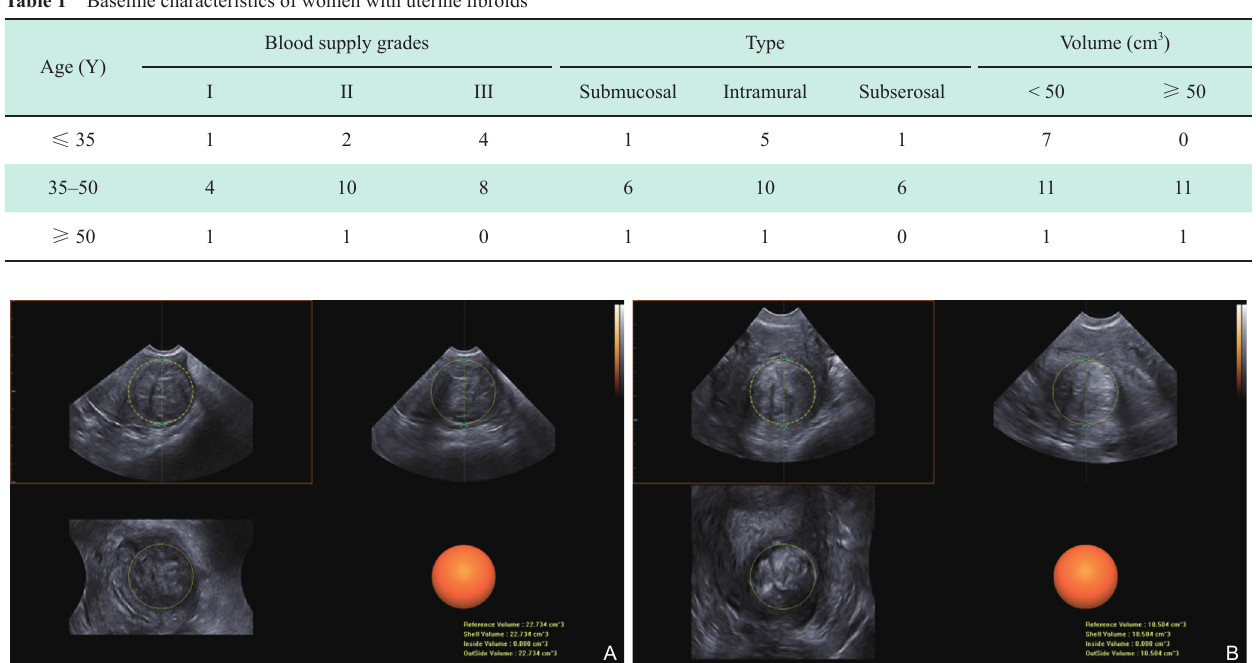
A B Figure 3 (A) Fibroid volume calculation using the 3D-PDA VOCAL software and spherical sampling before sclerotherapy; (B) Volume calculation of the same fibroid by using the VOCAL software and spherical sampling 6 months after sclerotherapy.